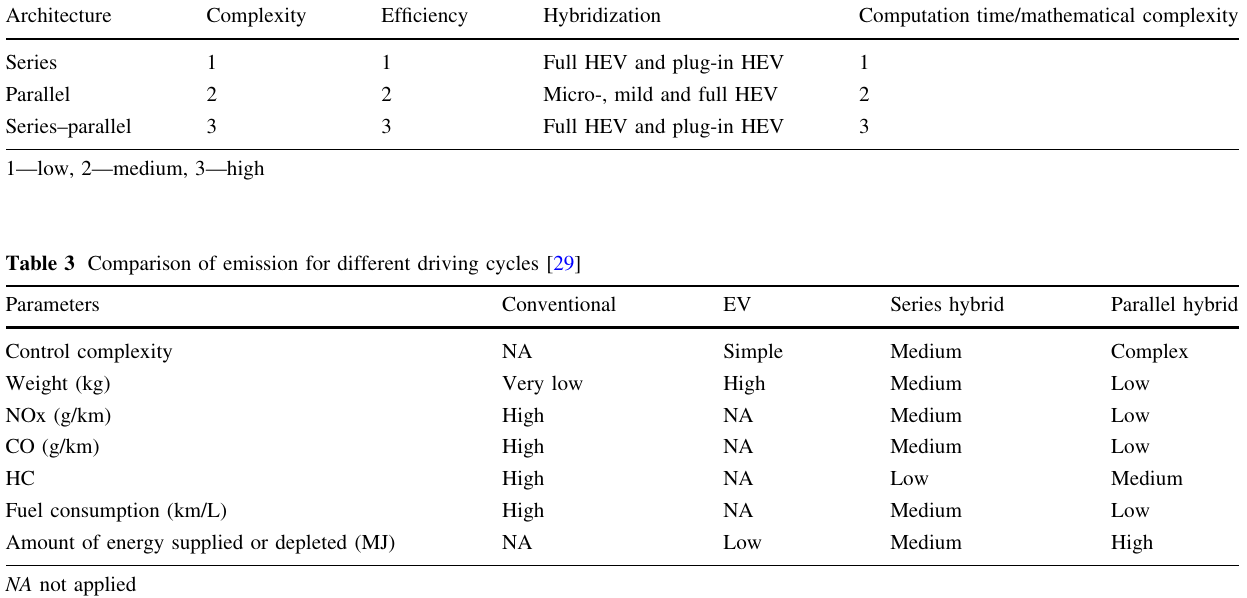
Table 2 Summary of architectures and their application Architecture